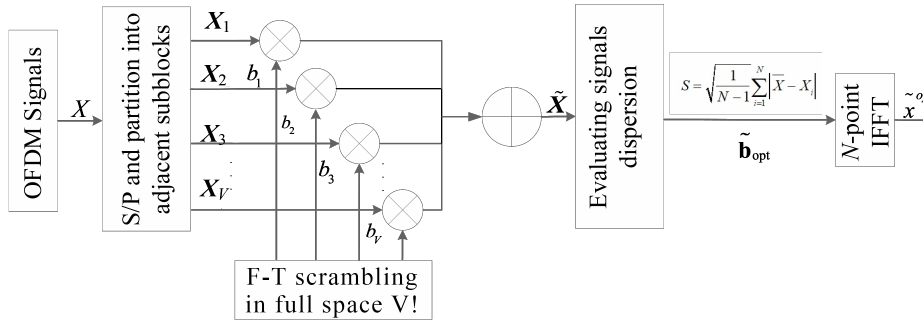
Figure 4. Structure of the F-PTS system.